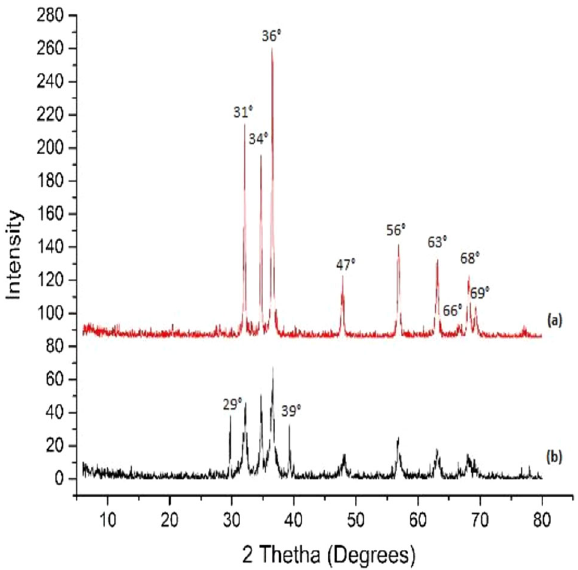
Fig. 2 XRD pattern showing peaks of ( a ) pure ZnO and ( b ) UDMA- grafted